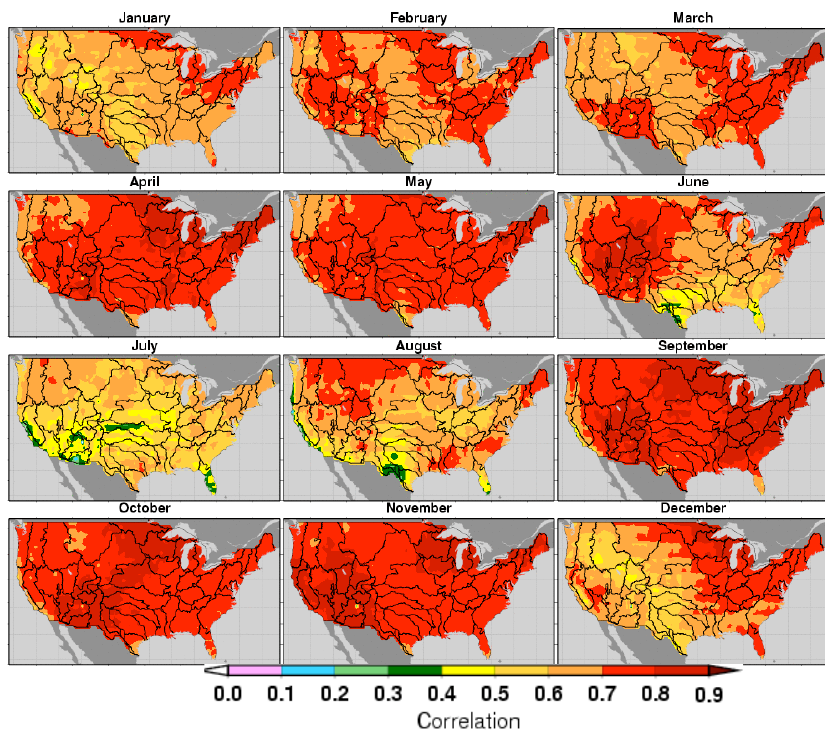
Fig. 3. Correlation between observed and forecasted (MRF) 14-day mean average-temperature during each month. Figure 3: Correlation between observed and forecasted (MRF) 14 days mean average 4 daily temperature during each month. 5